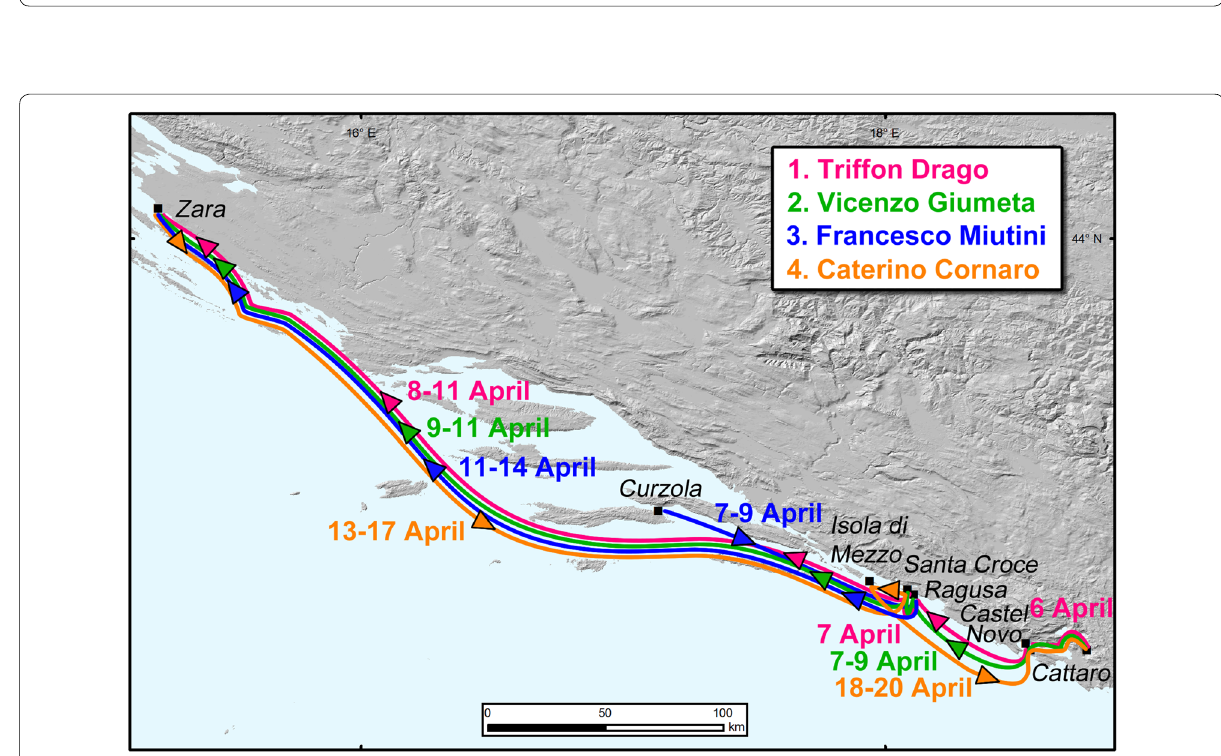
Fig. 3 Venetian officers and citizens travelling the Adriatic Sea in the 2 weeks after the earthquake. (1) and (2) from Cattaro to Zara; (3) from Curzola to Santa Croce and then Zara; (3) and (4) from Zara to Cattaro. From Albini (2015),